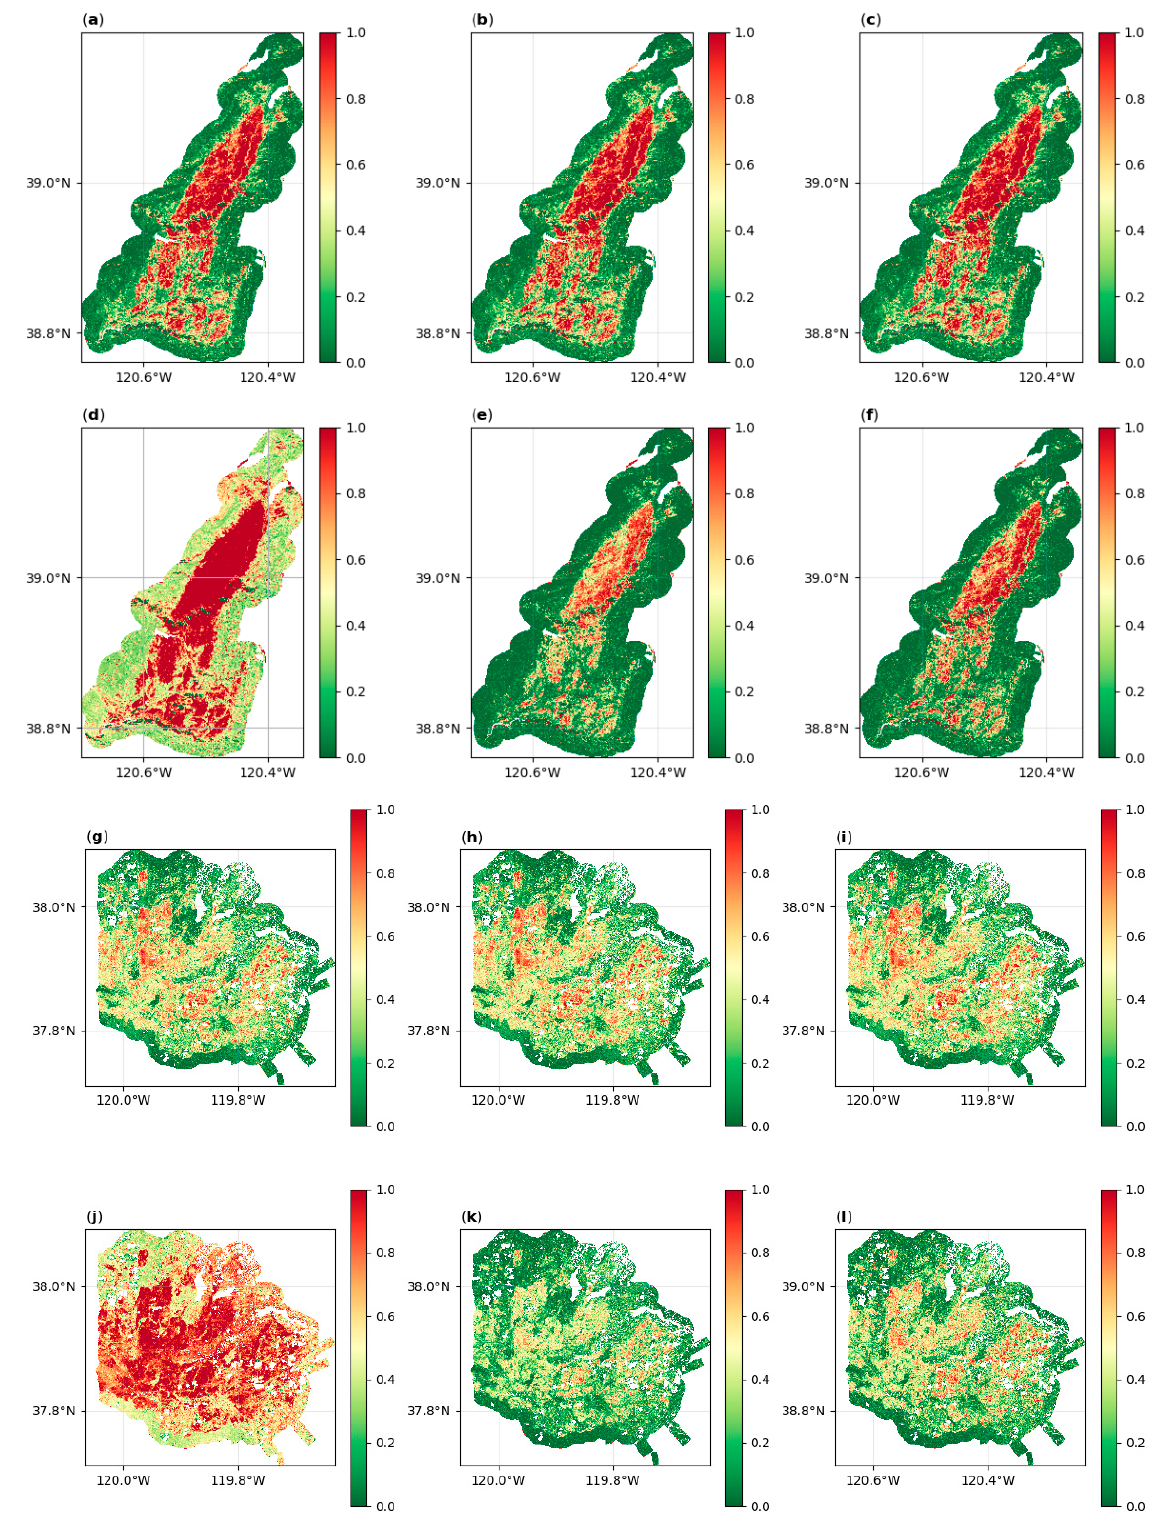
Figure 4. Pre- and post-fire differenced maps of both the King ( a – f ) and Rim ( g – l ). The colour display visualizes the differenced value of each pixel, the darker the red colours denote pixels with high fire severity values, green colours represent unaffected unburned pixels. ( a ) dNBR 1 King fire; ( b ) dNBR 2 King fire; ( c ) dNBR 3 King fire; ( d ) dNDVI MID,1 King fire; ( e ) dNDVI MID,2 King fire; ( f ) dNDVI MID,3 King fire; ( g ) dNBR 1 Rim fire; ( h ) dNBR 2 Rim fire; ( i ) dNBR 3 Rim fire; ( j ) dNDVI MID,1 Rim fire; ( k ) dNDVI MID,2 Rim fire; ( l ) dNDVI MID,3 Rim fire. Table 4. Fitting parameters, coefficient of determination (R 2 ) and root mean square error (RMSE) of the saturated growth regression models between spectral indices as independent variables and the Geometrically structured Composite Burn Index (GeoCBI) as dependent variable).